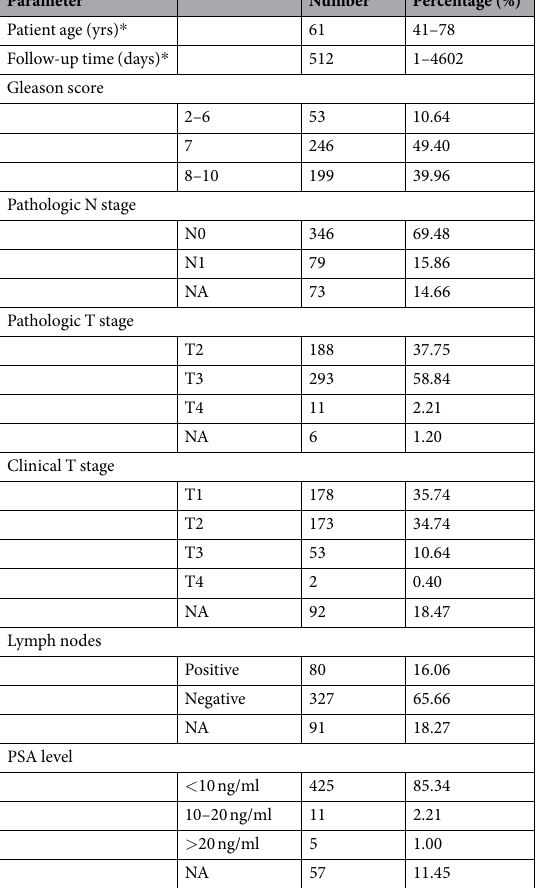
Table 2. The statistical association with molecular subtypes in different clinicopathologic characteristics across 498 tumor samples. (In this table, KW test indicated Kruskal-Wallis